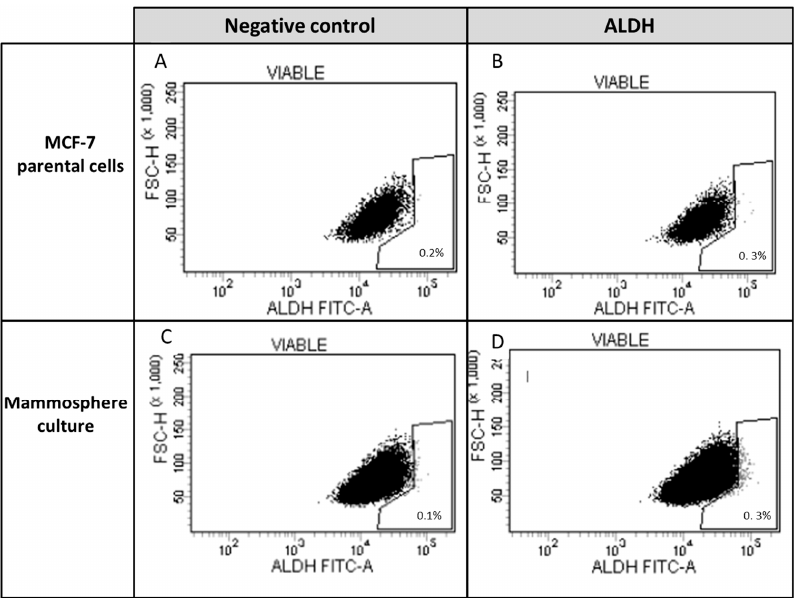
Figure 7. Expression of aldehyde dehydrogenase in parental MCF-7 cells and in mammospheres. Aldehyde dehydrogenase 1+ (ALDH1+) was analyzed by measuring cellular fluorescence of BODIPY-aminoacetate (BAAA) in ( A ) presence or ( B ) absence of DEAB, a specific ALDH1 inhibitor in parental MCF-7 cells and mammospheres, respectively ( C , D ). Stem cell fraction is shown in the gate (percent stem cell fraction = percent of ALDH1+ (DEAB − ) − percent ALDH1+ (DEAB+)). CD24low/CD44+ fraction was similarly increased in mammospheres in comparison with parental MCF-7 cells (from 1.3% in parental MCF-7 cells (Figure 8A) to 3% in mammospheres (Figure 8B)). SP fraction was similarly increased in mammospheres, compared to parental MCF-7 cells (0.5% in parental MCF-7 cells (Figure 8C) to 3% (Figure 8D)). In both MCF-7 (Figure 8E) or mammosphere